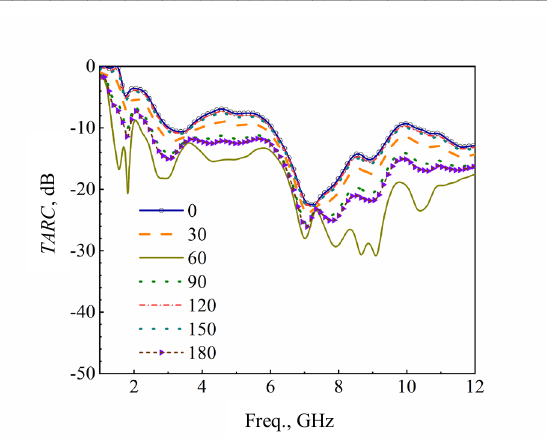
Fig. 14. Diversity gain of UWB/MIMO antenna.